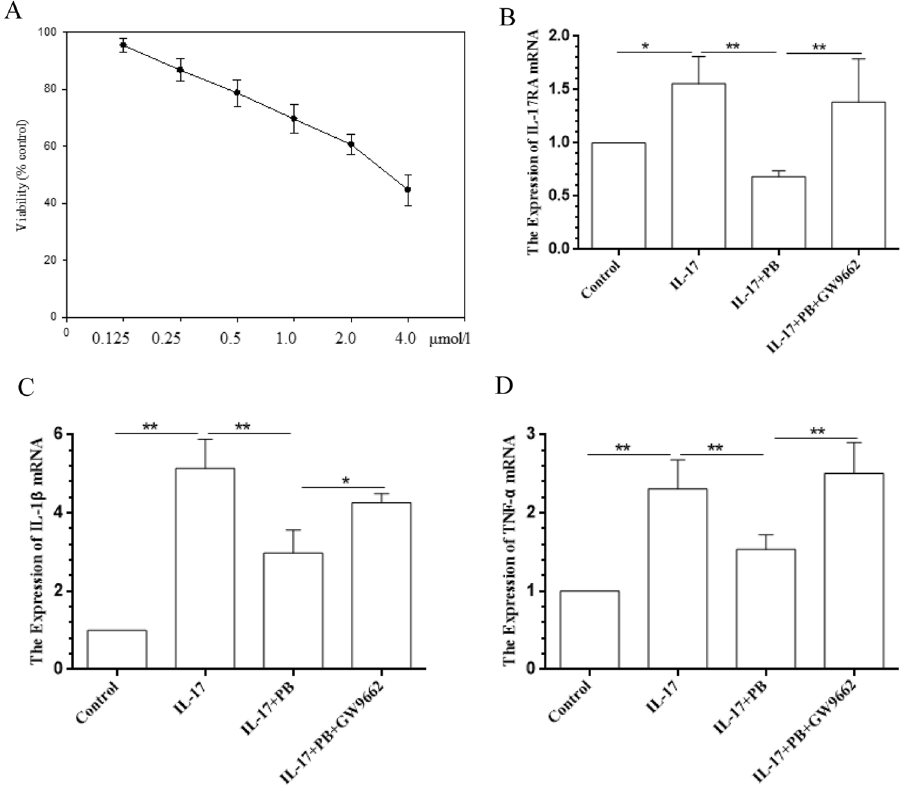
Figure 6. Effects of PB on IL-17-derived cytotoxicity and inflammatory response. ( A ) RAW264.7 cells were incubated with different concentrations (0, 0.125, 0.5, 1.0, 2.0, 4.0 μ mol/l) of PB for 24 h and cell viability was determined by the CCK-8 assay. In another experiment, RAW264.7 cells were pre-incubated with GW9662 (1.0 μ mol/l) for 1 h before added with PB (0.5 μ mol/l). After 21 h, cultured cells were stimulated with IL-17 (10 ng/ml) for 3 h. The mRNA levels of IL-17RA ( B ), IL-1 β ( C ) and TNF- α ( D ) were expressed as fold induction relative to control. Data are presented as mean ± SD. Each measurement was performed in duplicate and all experiments were repeated three times. * P < 0.05, ** P < 0.01.